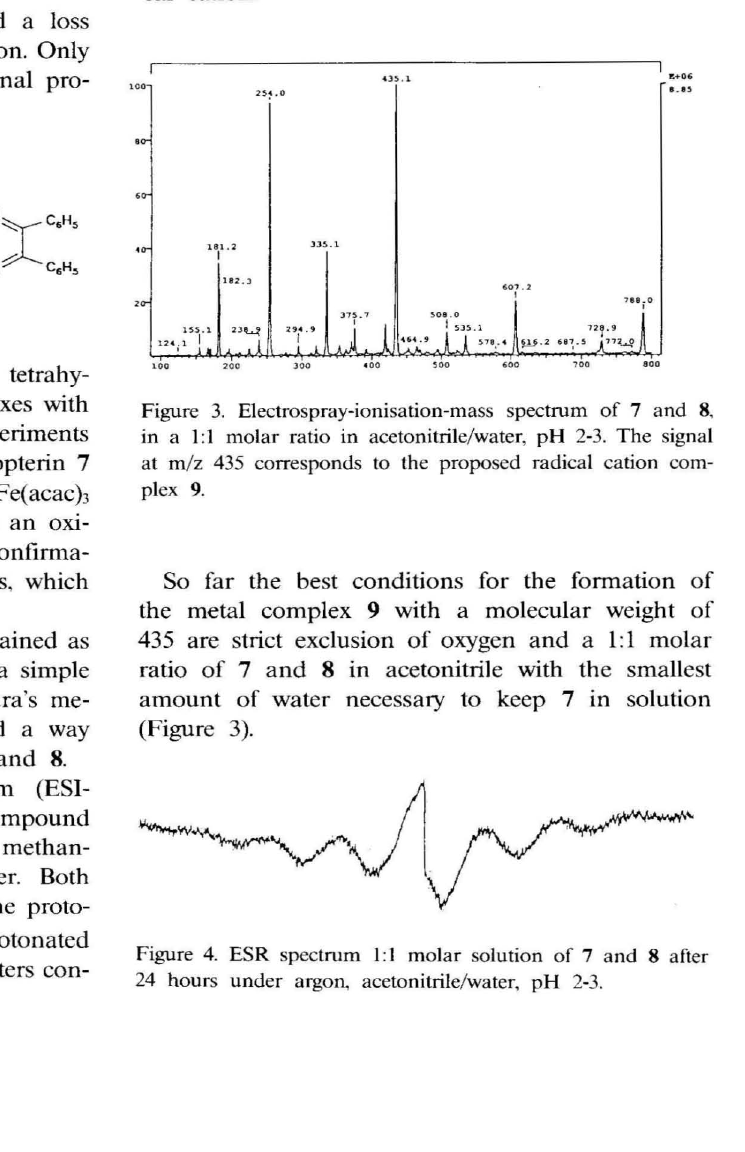
Figure 4. ESR spectrum 1:I molar solution of 7 and 8